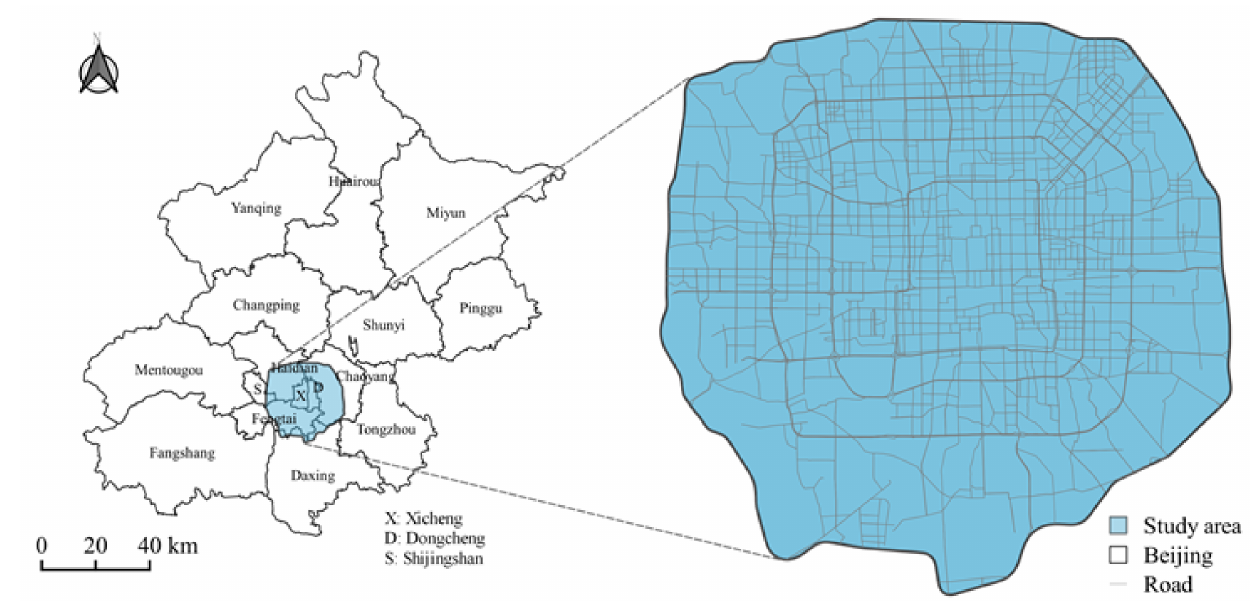
Figure 1. The study area within Fifth Ring Road in Beijing.